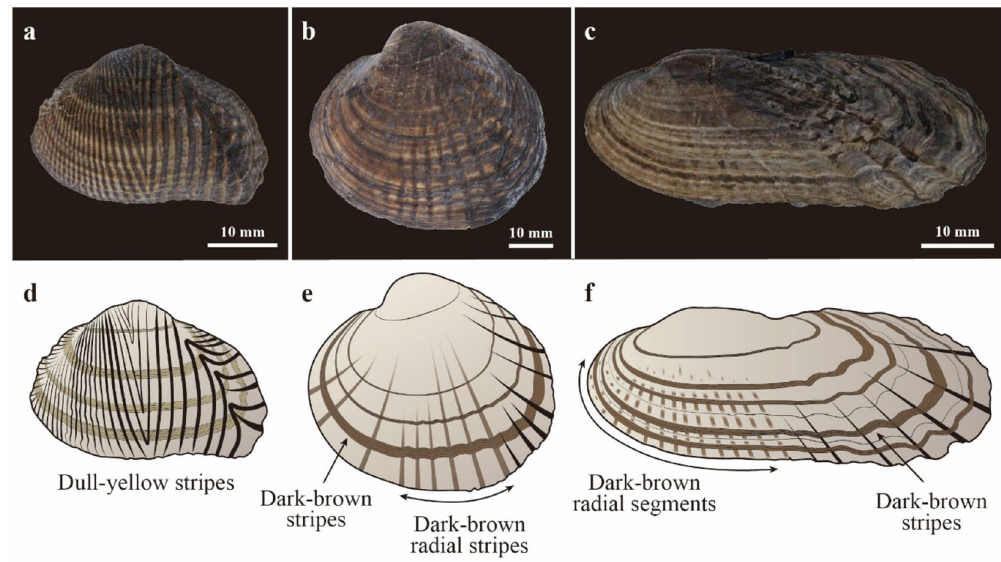
Figure 1. Color patterns of the Kitadani Freshwater Bivalves. ( a – c ) Water-immersion photographs of the Kitadani Freshwater Bivalves showing residual color patterns. ( a ) T . tetoriensis , FPDM-I-3445; ( b ) M . matsumotoi , FPDM-I-3456; ( c ) P . naktongensis , FPDM-I-3451. ( d – f ) schematic diagrams of reconstructed color patterns of the Kitadani Freshwater Bivalves. ( d ) T . tetoriensis ; ( e ) M . matsumotoi ; ( f ) P . naktongensis . Each color pattern was drawn based on the following specimens: ( d ) Fig. 1a, Extended Data Figs. 8a,c, 9a,c and 10a,c. ( e ) Fig. 1b, Extended Data Figs. 17a,c, 18a,c and 19a,c. ( c ) Fig. 1c, Extended Data Figs. 12a,c, 13a,c, 14a,c and 15a.